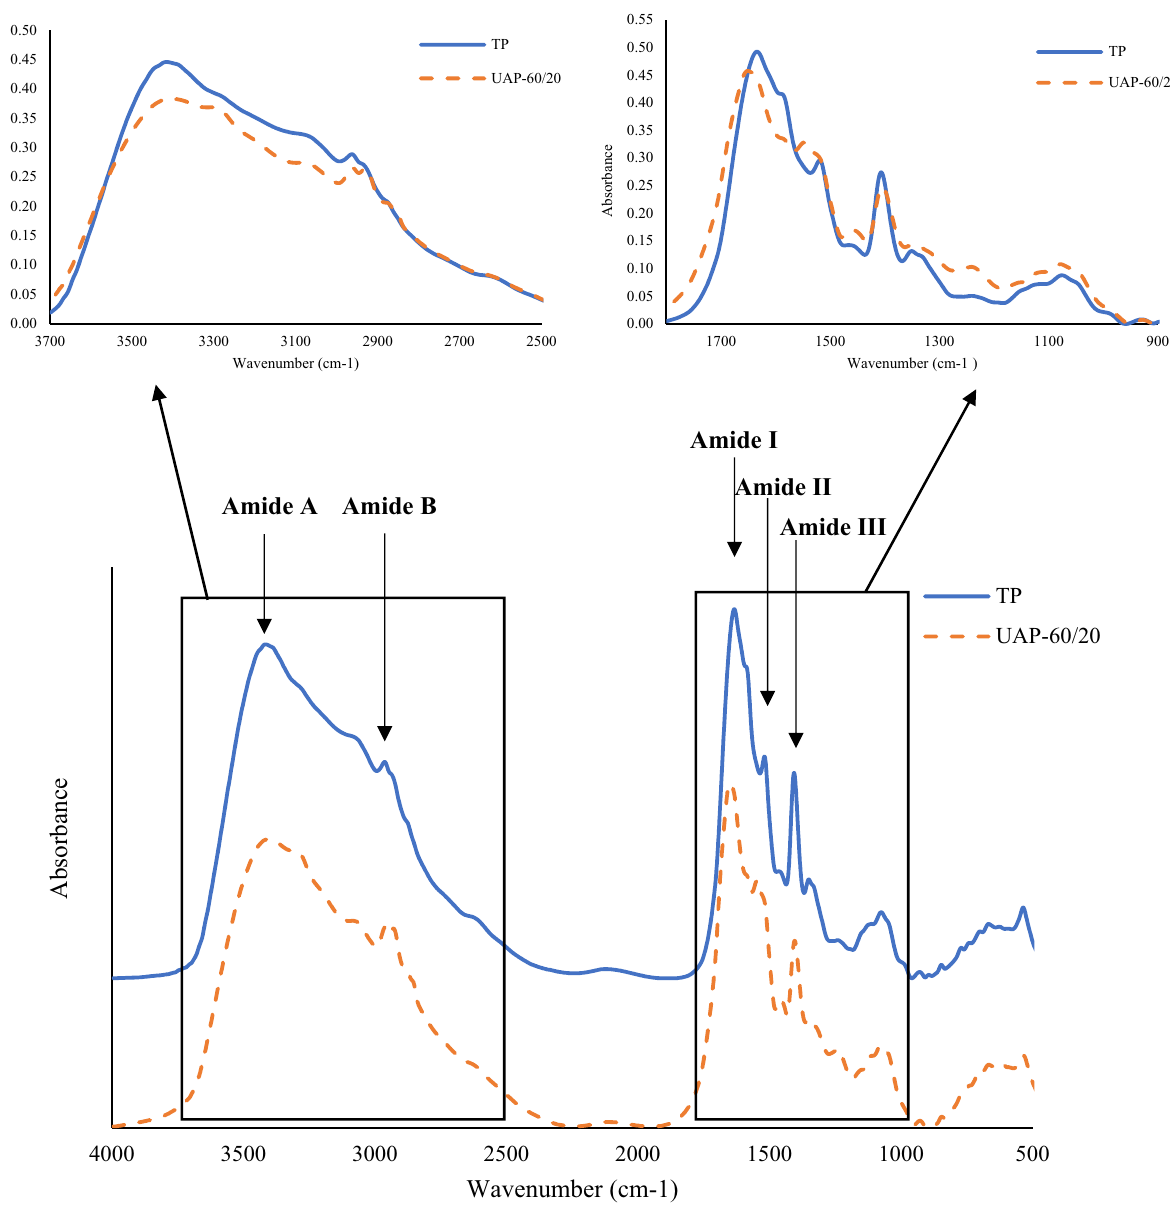
Figure 4. FTIR spectra of protein extracted from Bombay locust by selected ultrasound-assisted process at 60% amplitude for 20 min (UAP-60/20) and typical extraction process